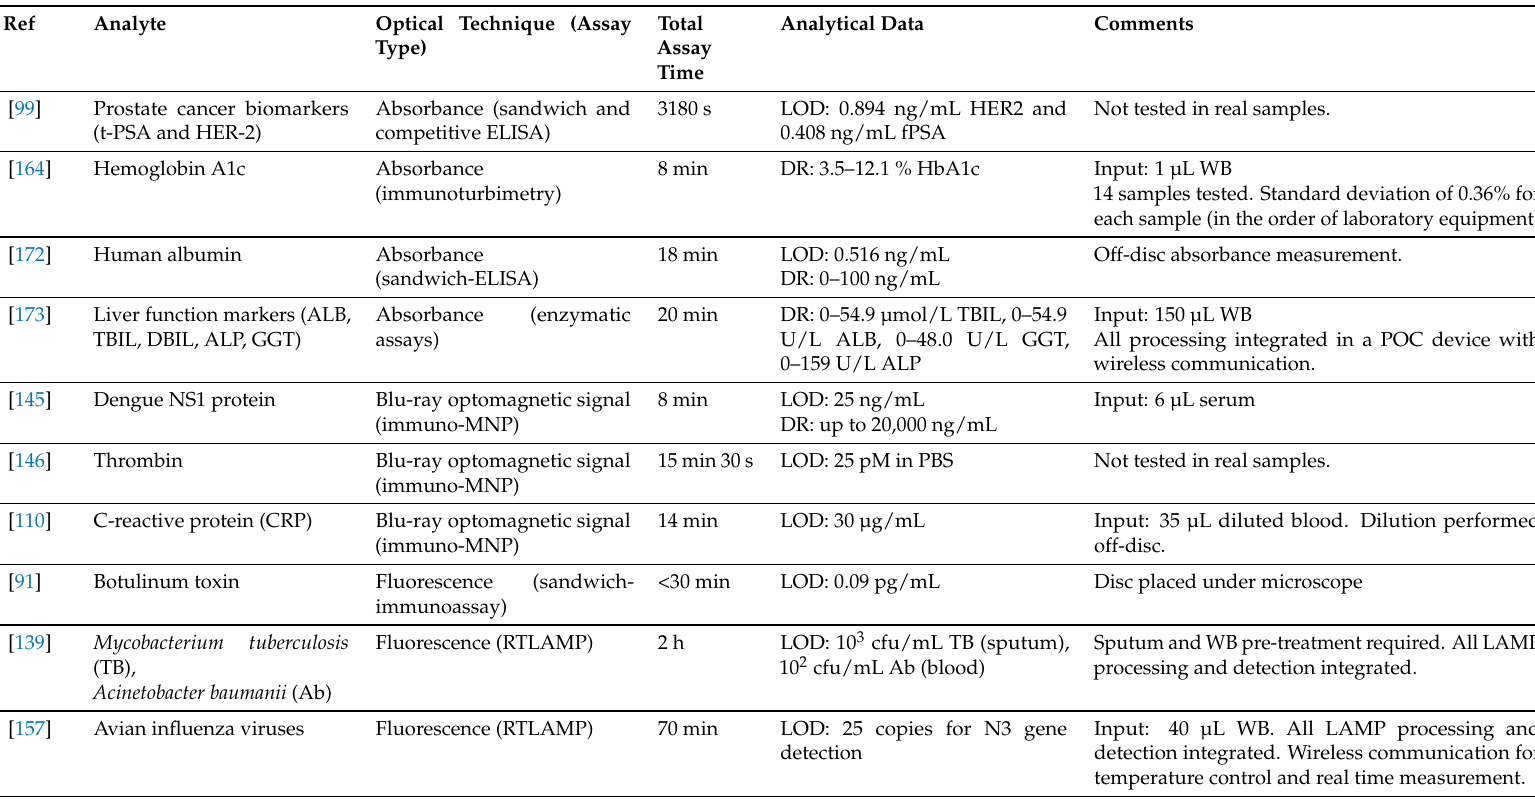
Table 3. Summary of some optical detection-based LoaD biosensors. DR: detection range, LOD: limit of detection, WB: whole